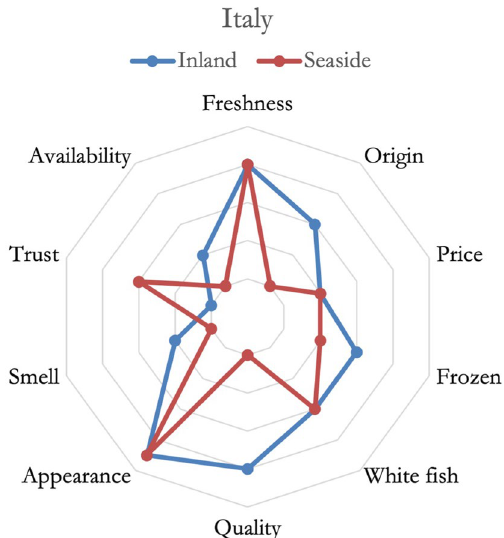
Fig. 5 Importance of fish attributes in defining consumer’s preferences, Italy